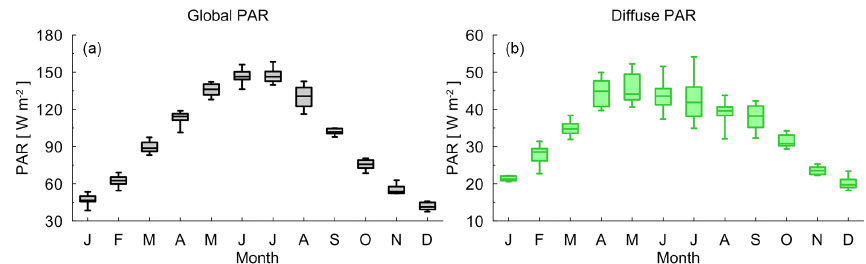
Figure 3. Annual evolution of median, lower and upper quartiles, maxima, and minima of global (a) and diffuse (b) monthly average